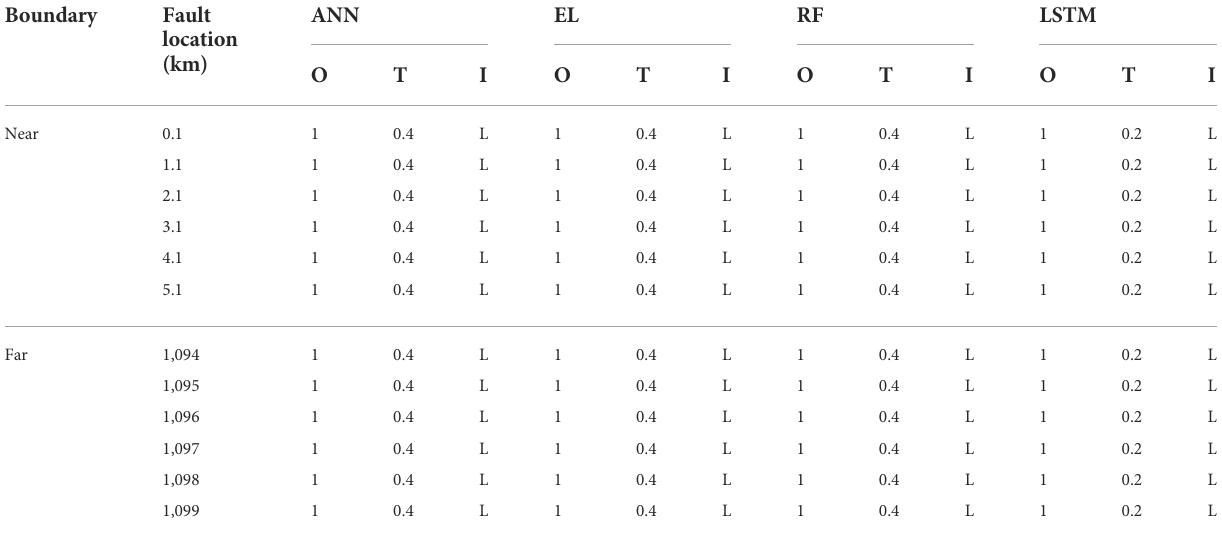
TABLE 6 Performance results with boundary fault.